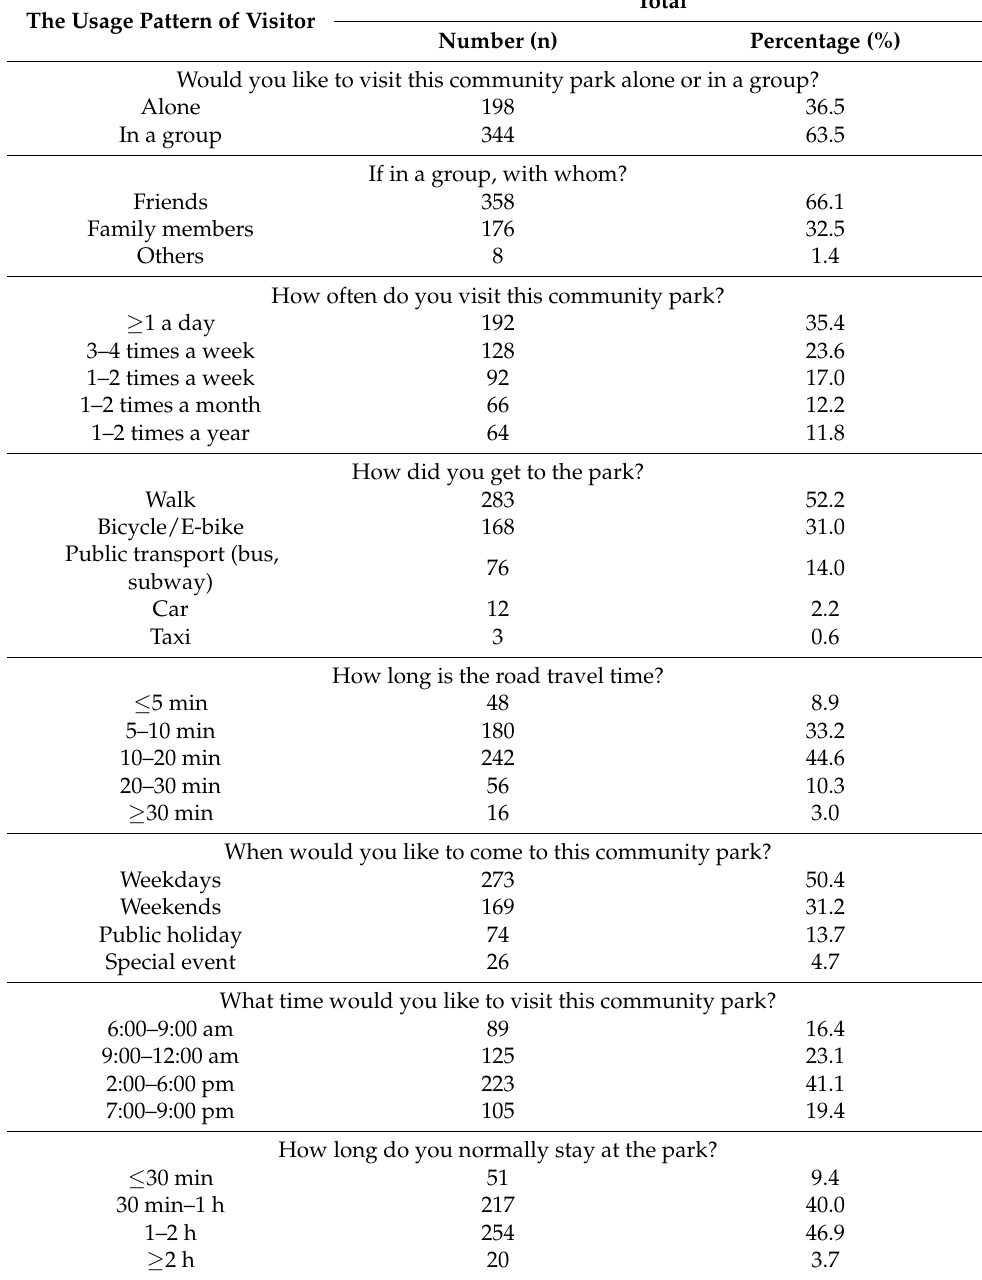
Table 3. Analysis of visitor usage